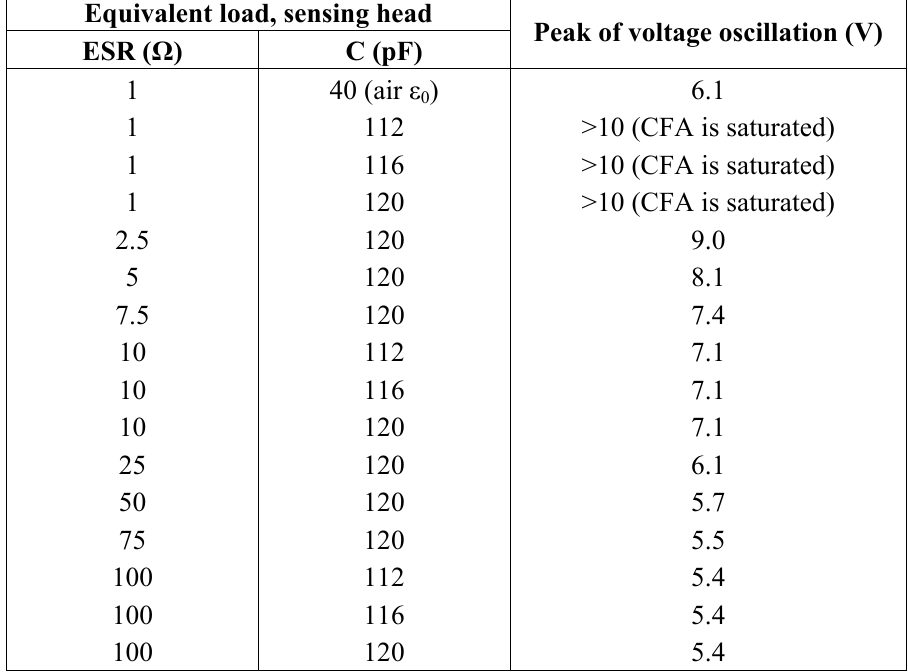
Table 5. Simulation results for the equivalent sensing circuit.